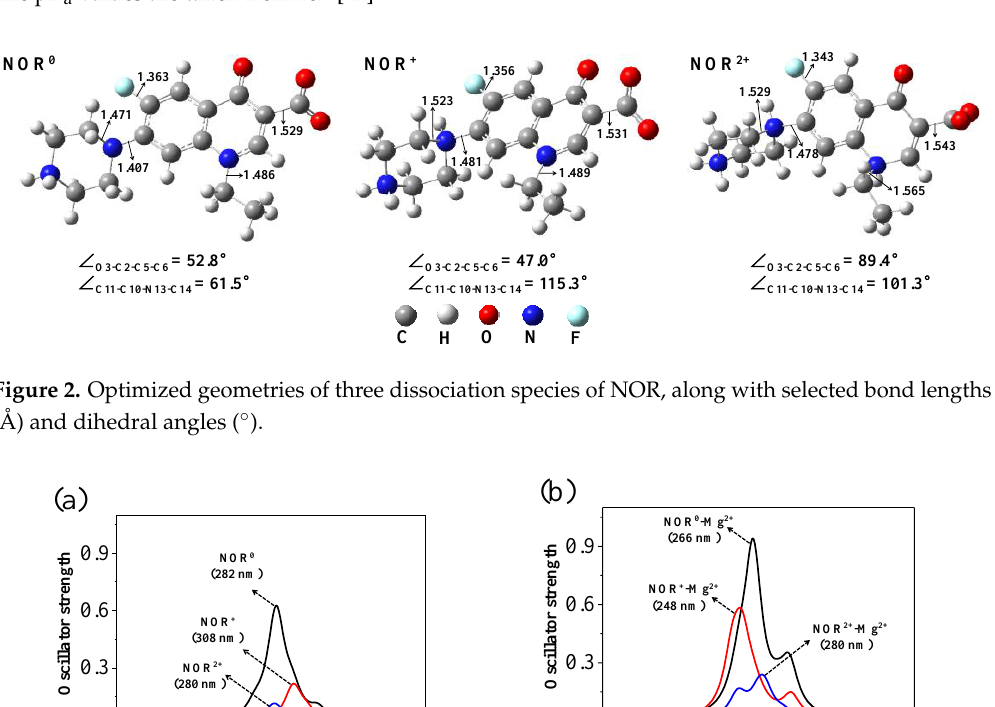
Figure 1. Structural formulae of norfloxacin (NOR) and numbering scheme for atomic positions. The p K a values are taken from ref. [41].